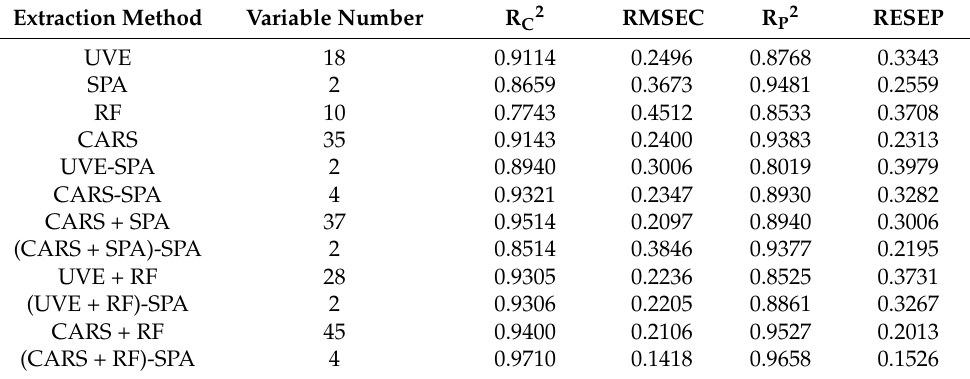
Table 7. Prediction results of BPNN model established by different feature extraction methods. Extraction